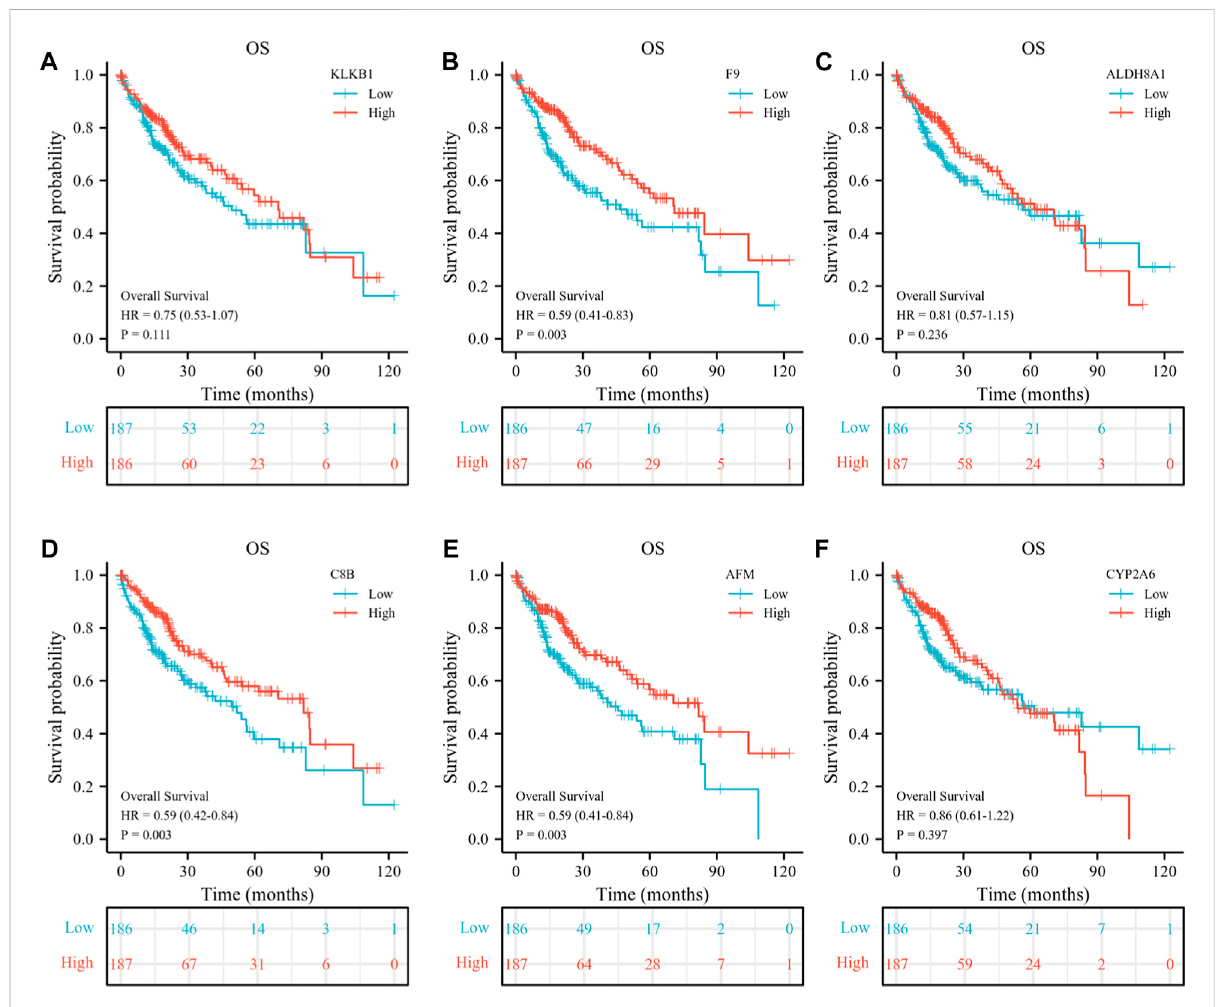
FIGURE 10 Prognosticanalysis of sixdown-regulated hub genes. (A – F) Associationbetween KLKB1 (A) , F9 (B) , ALDH8A1 (C) , C8B (D) , AFM (E) ,and CYP2A6 (F) expressions and overall survival (OS) were performed with the Kaplan – Meier survival